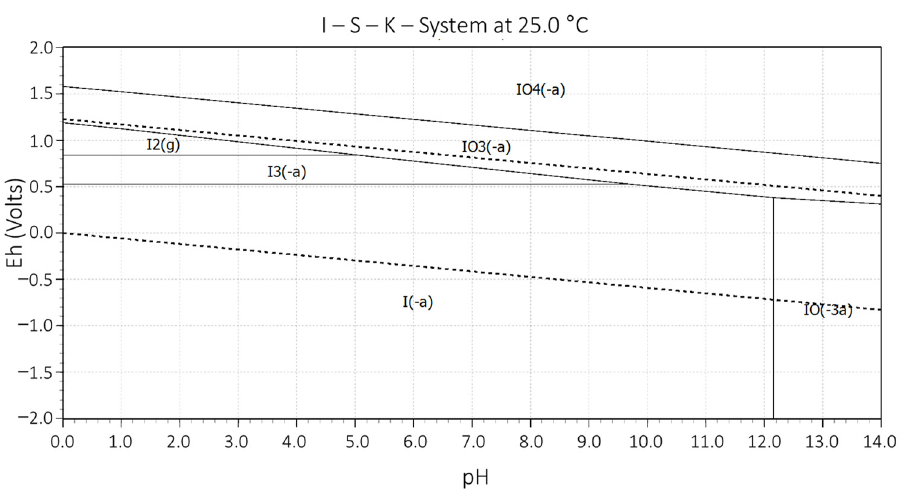
Figure 1. Eh–pH diagram system I-O. [I] = 0.001 M.